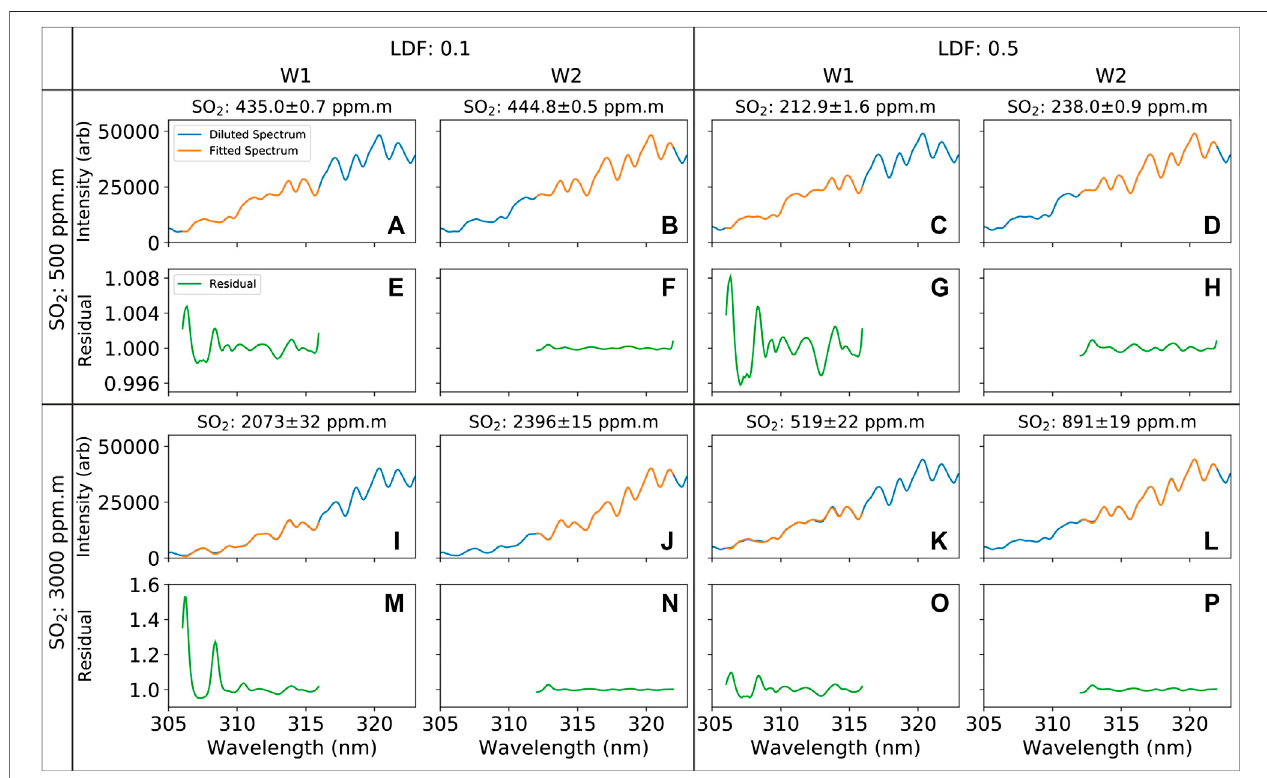
FIGURE 5 | Synthetic spectra (blue) are created from a single Masaya spectrum by varying SO 2 SCD and LDF in the altered forward model (run between 305 and 323 nm).ThesespectraarethenanalyzedusingthetraditionaliFit,creatinga fi ttedspectrum(orange). (A,C,I,K) show fi tsforW1(306 – 316),while (B,D,J,L) show fi tsfor W2 (312 – 322 nm). The retrieved values are shown above each spectra plot. Residuals of these fi ts are shown (green), calculated as the synthetic model spectrum divided by the fi tted spectrum (E – H,M – P) . Note the scale for the residual plots is much larger for the 3,000 than 500 ppm m plots.